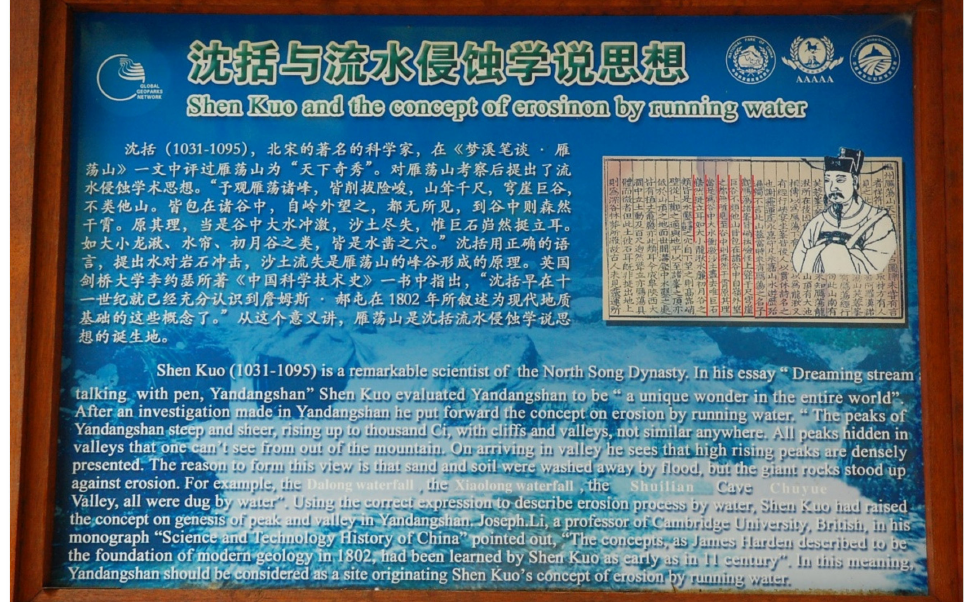
Figure 6. Interpretation panel in Yandangshan UNESCO Global Geopark, China, referring to the history of scientific inquiry in the field of geosciences (photograph by the